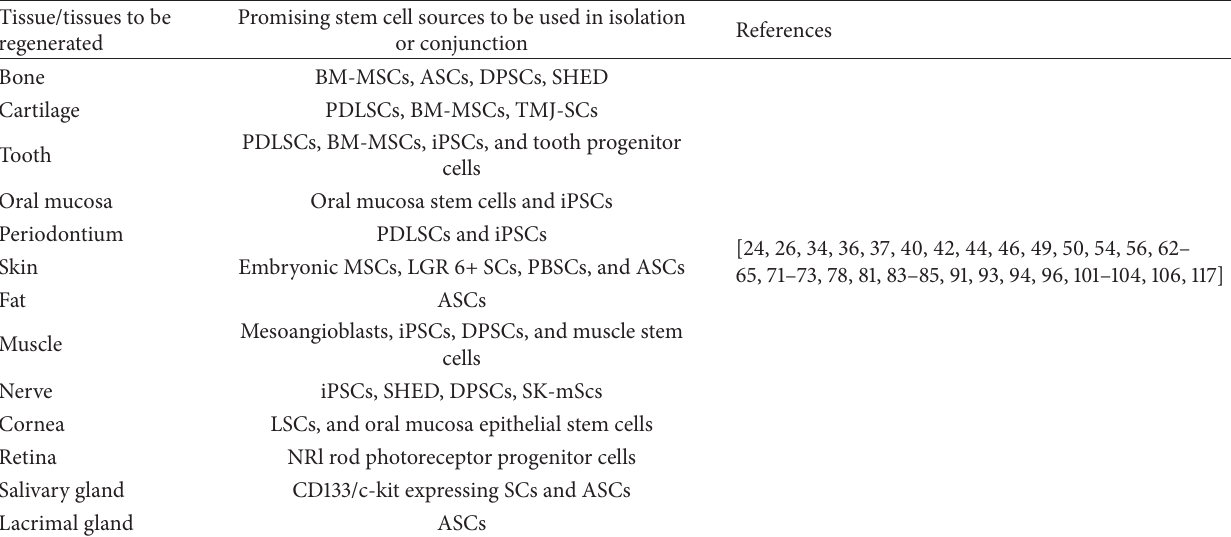
Table 4: This table presents a general summary of target tissues or organs in need of superior regenerative solutions and the corresponding stem cell types evidenced with feasible regenerative